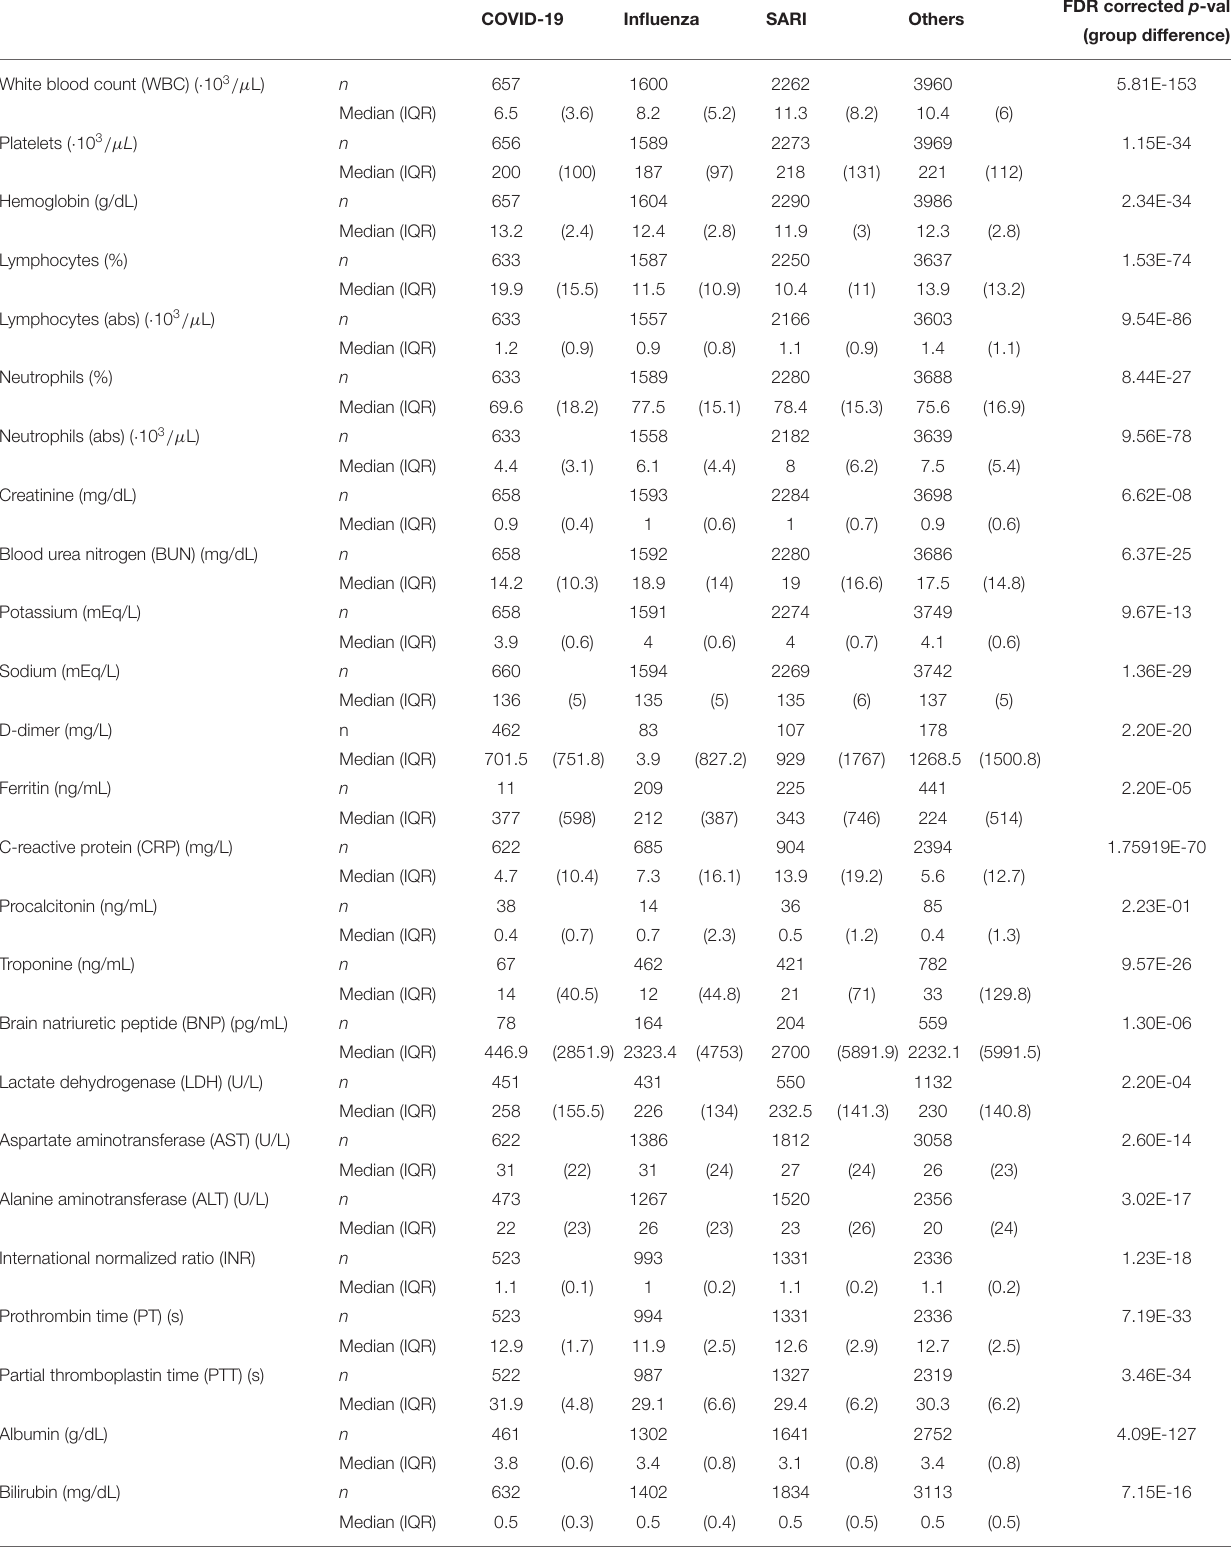
TABLE 4 | Laboratory examinations at